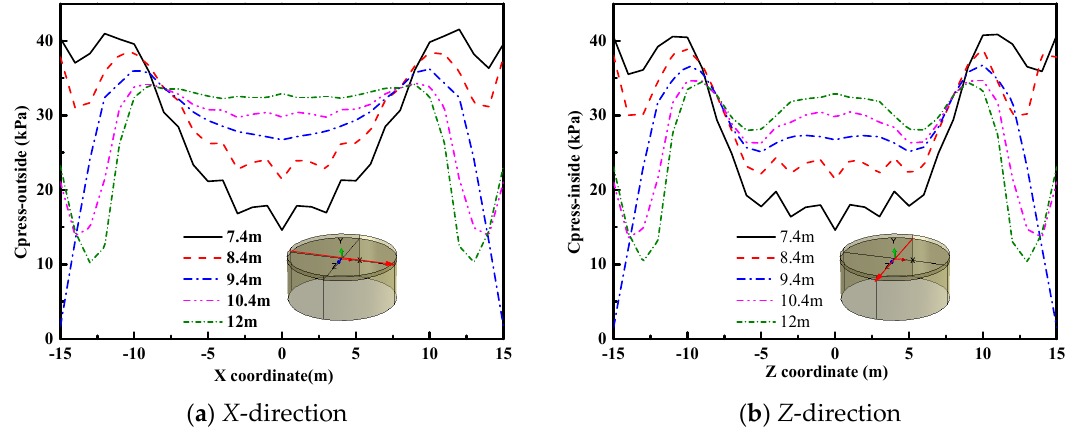
Figure 10. Contact stress of the bucket lid under different bucket skirt heights.